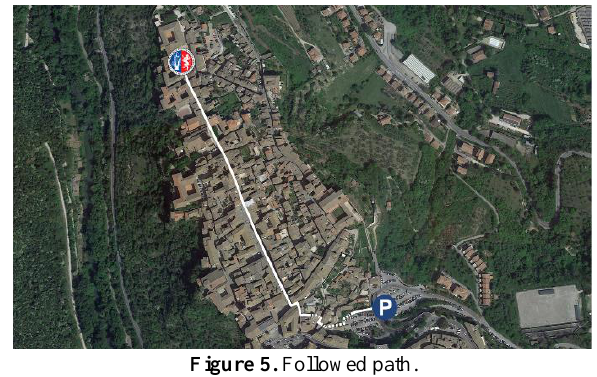
Figure 5. Followed